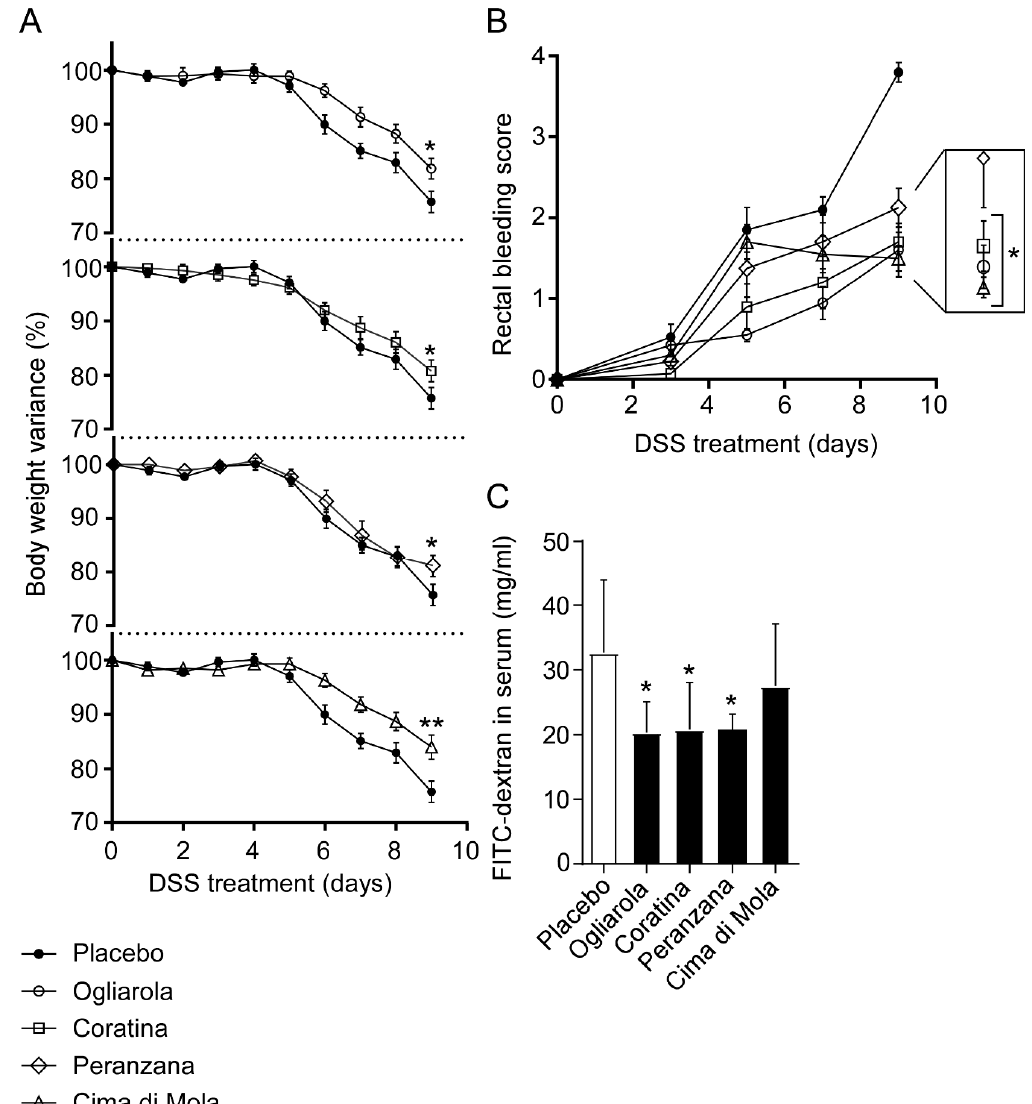
Figure 2. Apulian EVO cultivars treatment reduces (A) body weight loss, (B) rectal bleeding and (C) intestinal permeability in DSS-treated mice. Mice were treated with Ogliarola, Cima di Mola, Coratina, Peranzana EVO and placebo by oral gavage starting a day prior to DSS administration through 10th day. ( A ) Percentage of body weight variance during DSS treatment, ( B ) visible rectal bleeding score, ( C ) In vivo intestinal permeability measurement after DSS-induced intestinal inflammation in C57Bl/J6 mice. All values represent means ± SD. Differences between means were tested for significance using 1-way ANOVA followed by the Bonferroni test (* p < 0.05).